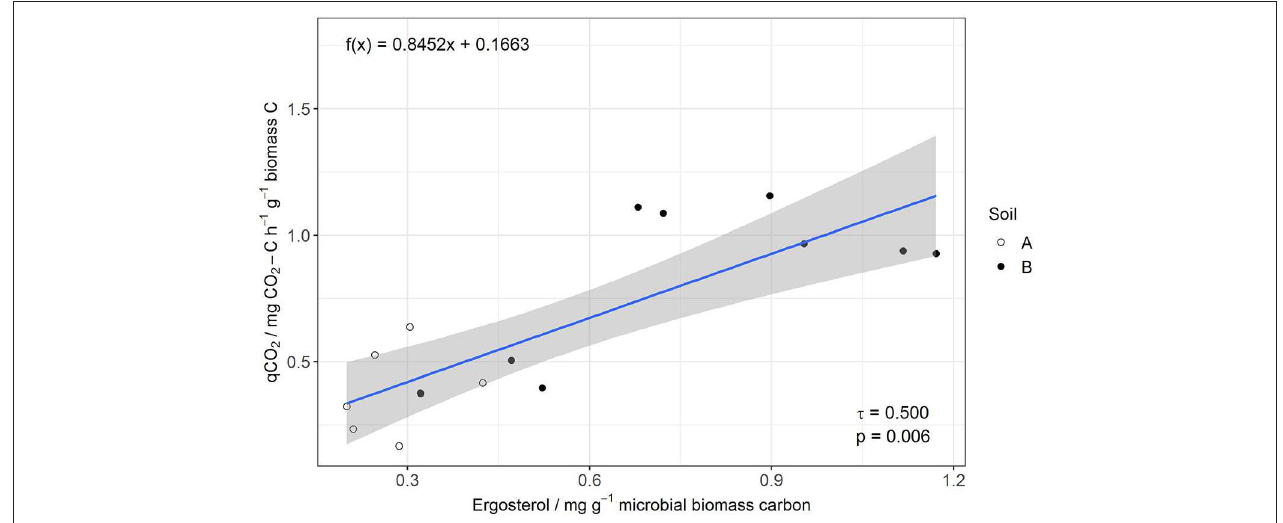
FIGURE 3 | Linear regression of q CO 2 (y) and Erg-to-MBC (x) for the control without manure and rice straw